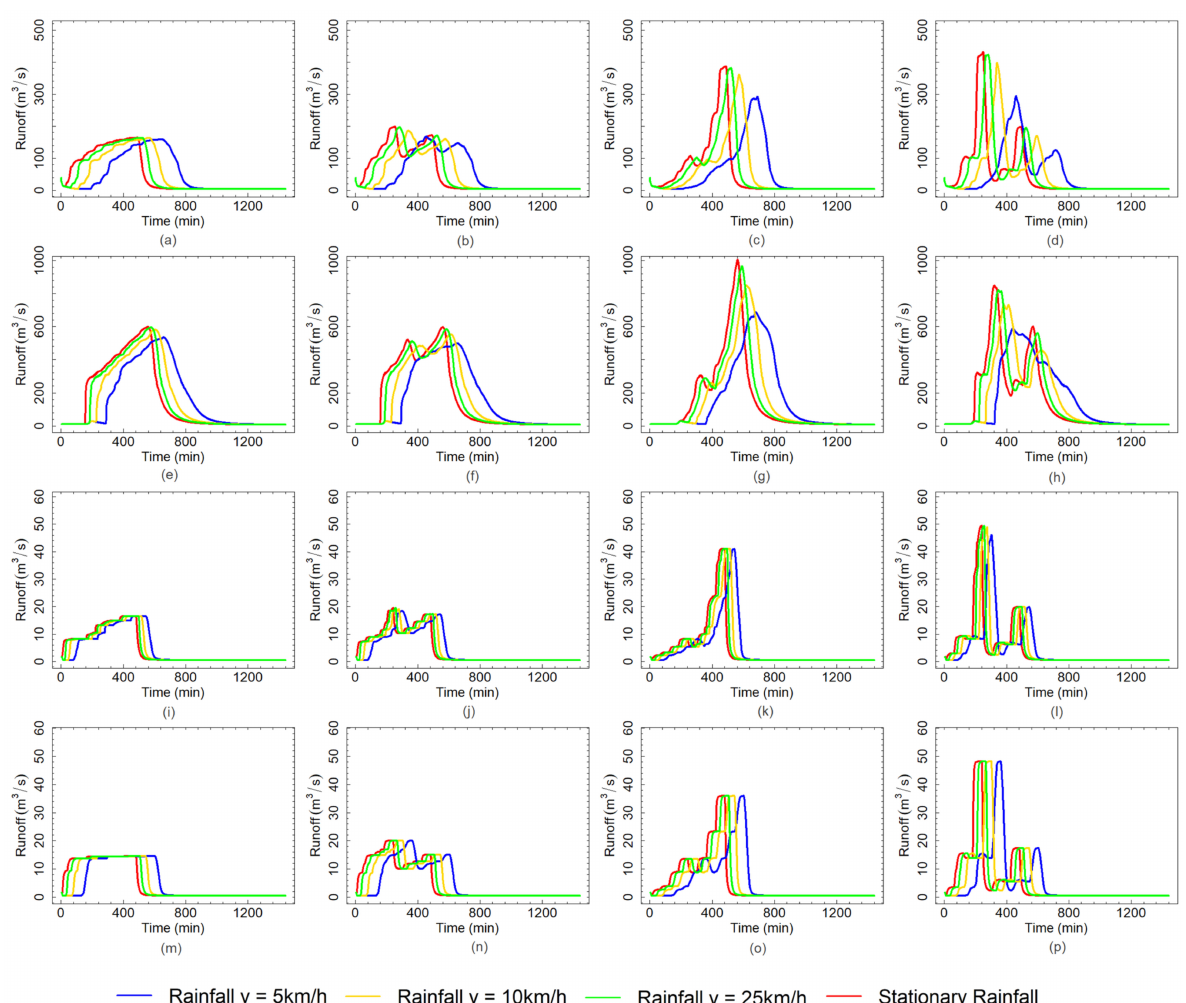
Figure 7. Hydrographs for four generated rains (Figure 3a,b,e,f from left to right respectively) under the stationary and moving setups with velocities v = 5 km/h, v = 10 km/h, v = 25 km/h with a direction from west to east at measuring points B ( a – d ), C ( e – h ), D ( i – l ), E ( m – p ) (Figure